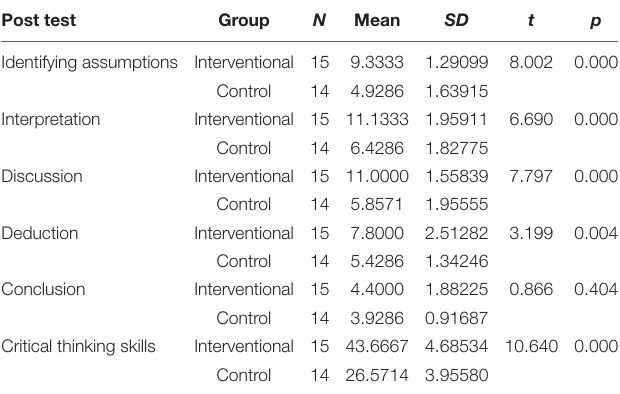
TABLE 5 | Independent sample t -test for the critical thinking post-test.